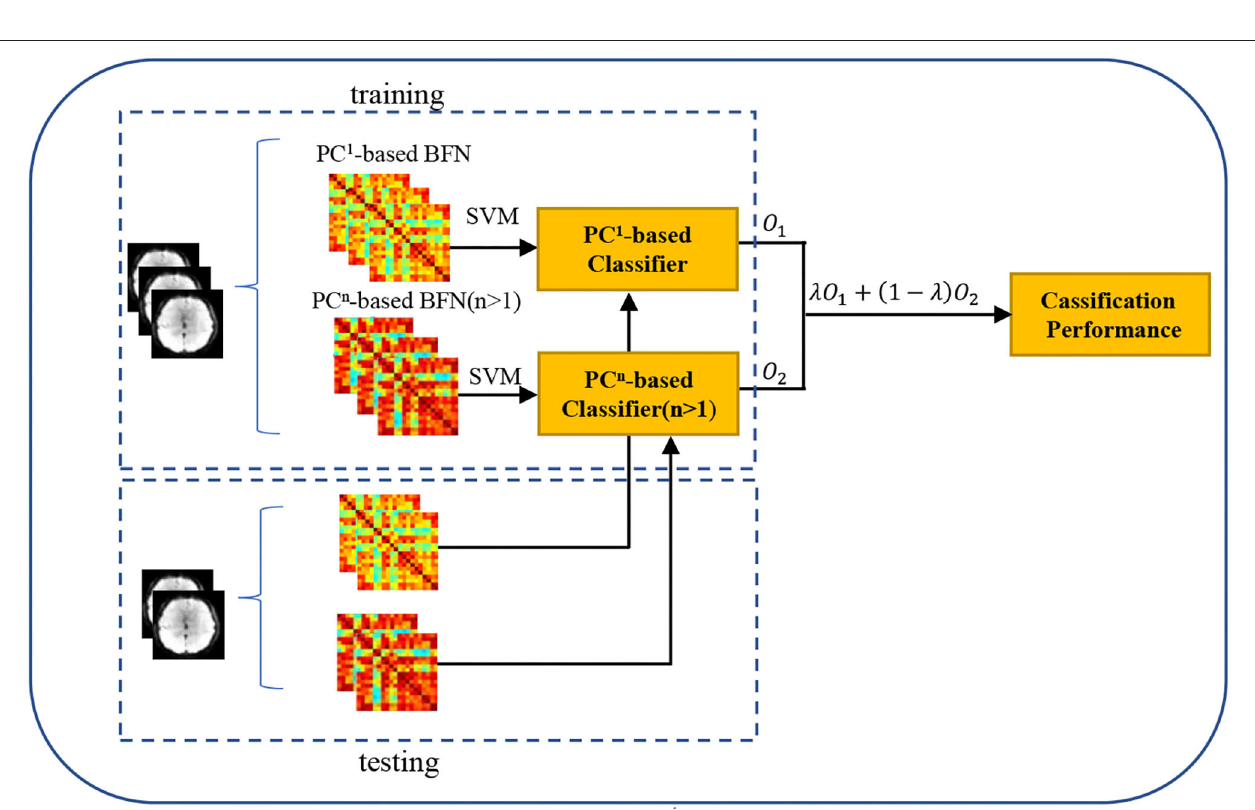
FIGURE 4 | The classification pipeline based on the PC 1 - and PC n (n>1)-based BFNs. We first train two classifiers based on the PC 1 - and PC n ( n > 1)-based BFNs, respectively, and then fuse the outputs (i.e., O 1 and O 2 ) of the two classifiers via λ O 1 + (1 − λ ) O 2 , where λ is the optimal parameter obtained by an inner 5-F CV.